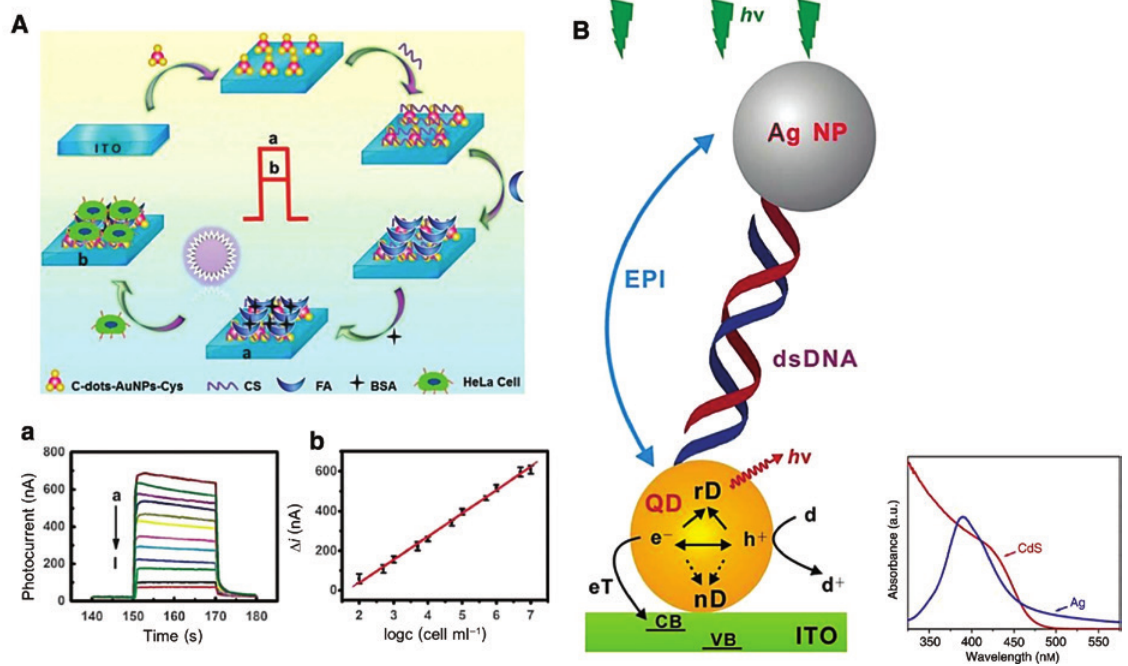
Figure 6: (A) Schematic representing the label-free ultrasensitive PEC cytosensors based on C-dots-AuNPs-Cys before (a) and after (b) cap- turing HeLa cells. Plots: PEC responses obtained from the cytosensor for various concentrations of HeLa cells from 0.1 × 10 2 to 1 × 10 7 (a–i) cell ml −1 and the corresponding calibration curve. Reprinted with permission from Ref. [185]. Copyright 2012; American Chemical Society. (B) Illustration of PEC between QDs and AgNPs bridged with dsDNA. The PEC involved several steps of light irradiation: photon absorption, which led to electron excitation of QDs, thus generation of electron-hole pair; hole scavenging by means of electron donor (d);